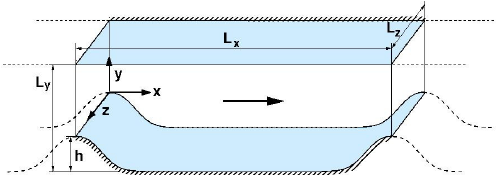
Figure 5. The hill flow